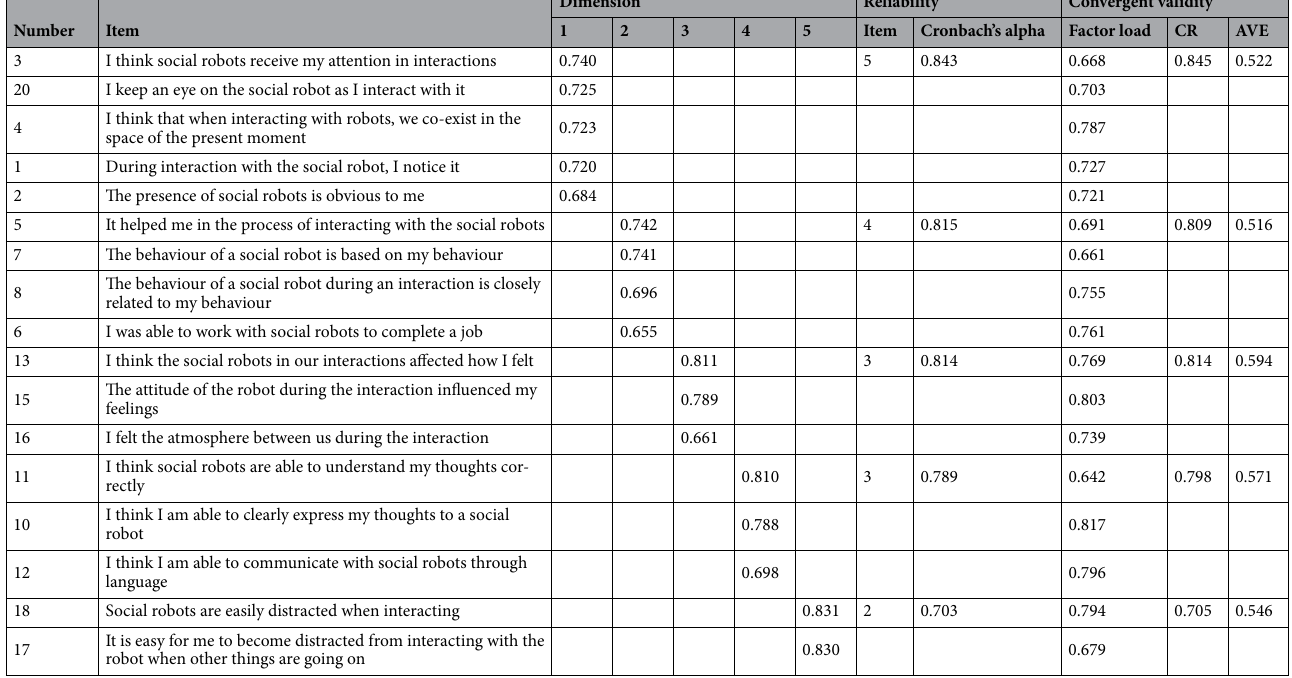
Table 8. Exploratory factor analysis of the final questionnaire